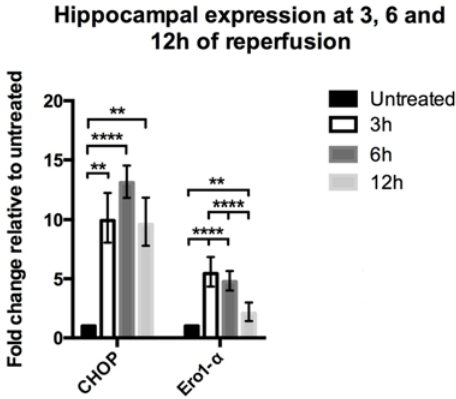
Figure 1. Hippocampal expression of CHOP and Ero1- α following global ischemia. Quantitative PCR revealed a significant increase in expression of CHOP and Ero1- α induced by global ischemia over a time course of 12 h. The greatest expression level of CHOP is detected at 6 h of reperfusion ( n = 6) compared to untreated animals ( n = 10), ( p < 0.0001). At 3 h ( n = 7) and 12 h ( n = 6) after induction of ischemia similar expression levels of CHOP were observed, significantly greater than in the untreated group ( p < 0.01). No difference between the different time points was detected. Ero1- α was significantly increased at 3 h ( n = 5), 6 h ( n = 7) and 12 h ( n = 5) of reperfusion ( p < 0.0001 and 0.01 respectively), with greatest expression levels at 3 to 6 h followed by a decrease. Data analyzed by one-way ANOVA followed by Tukey’s multiple comparisons test. ** p < 0.01 and **** p <